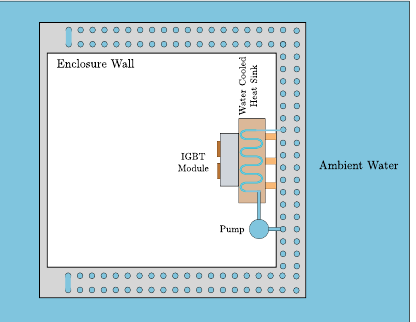
Figure 3. Active cooling: Water is passed through a heat sink on which the IGBT modules are mounted. The coolant then exchanges the heat with the ambient seawater through a separate heat exchanger, which may be embedded in the enclosure walls. This is only a representative diagram; heat exchangers on the cabinet surface can look differently than presented